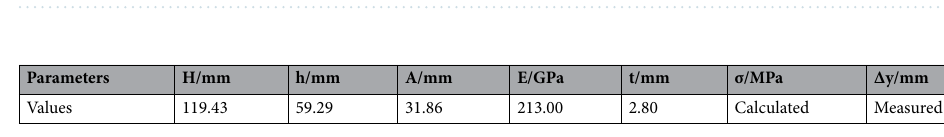
Figure 2. Schematic diagram of four-point bending ( a ) without loading, ( b ) during loading.